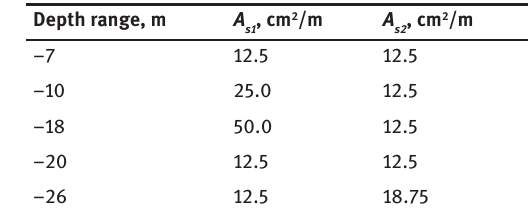
Table 1: Preliminary design of reinforcement in the wall based on the results achieved for Case A1.